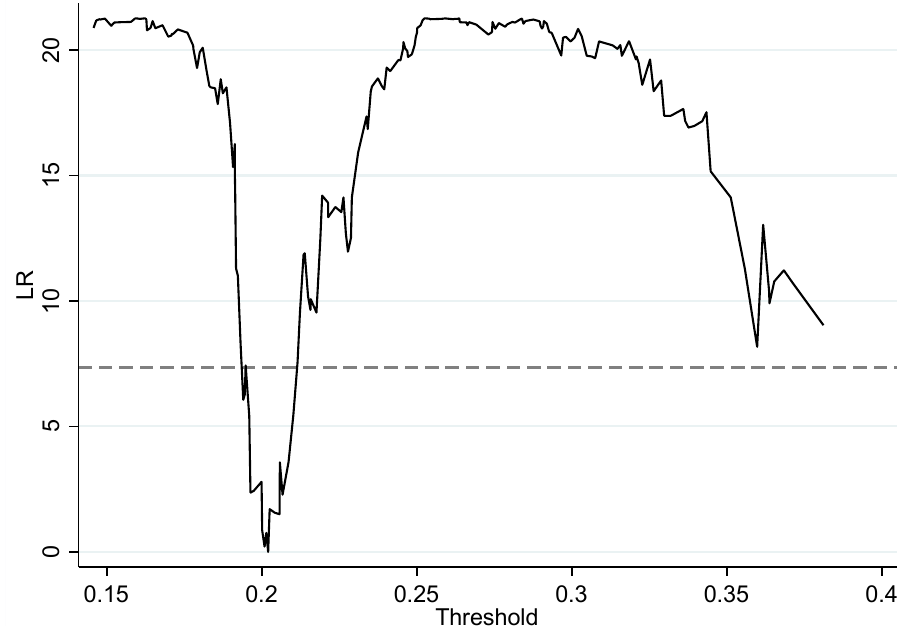
Figure 3. Threshold estimates and confidence intervals.